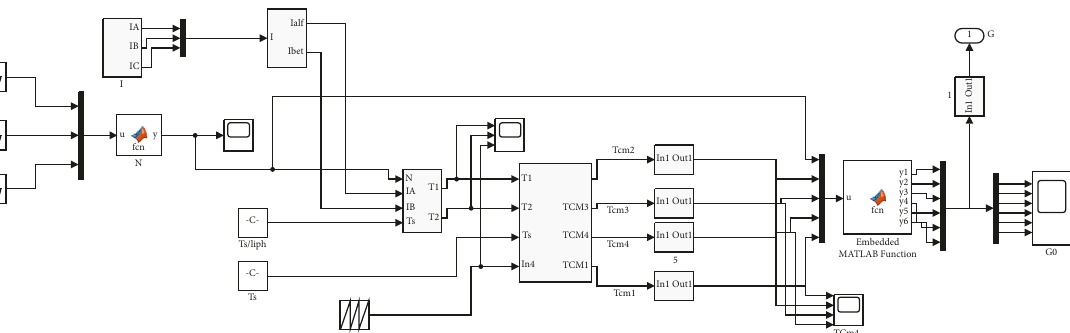
Figure 6: Driving pulses generation of the preceding regulated MR.